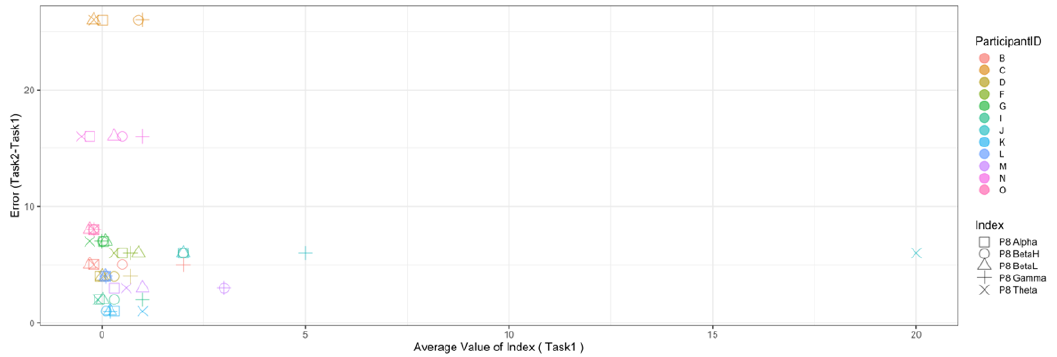
Figure 12. Scatterplot between the number of errors of Task2 vs. the EEG indexes during Task1. (Note that the scatterplots include only EEG channels with significant correlations (AF3 and P8), as summarized in Table 17).